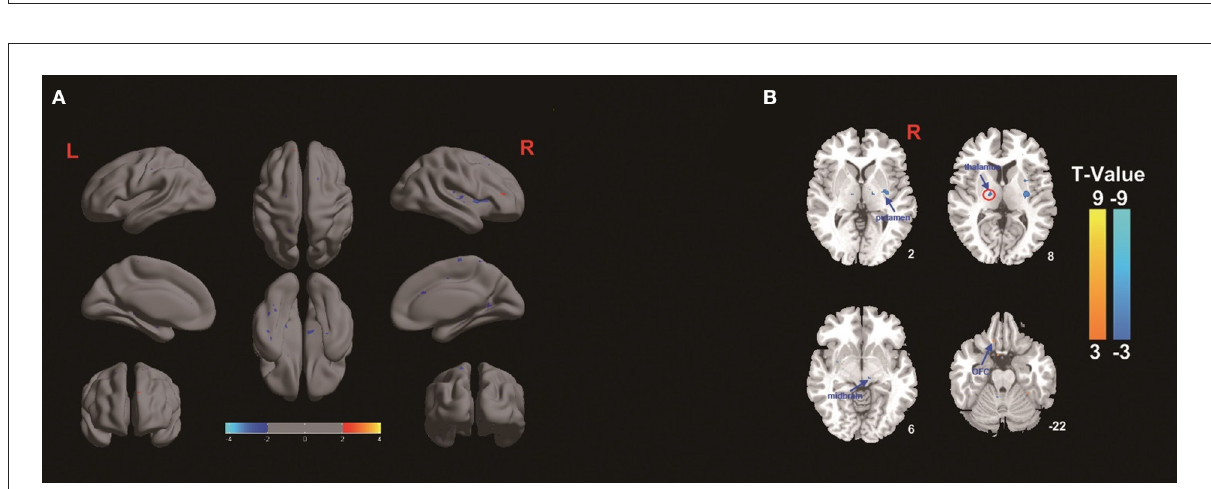
FIGURE3 (A,B) ALFF differences in healthy volunteers between the TEAS group and the control group. The warm color shows increased ALFF values in the OFC in the TEAS group, while the cold color shows decreased ALFF values in the left thalamus, right putamen, and midbrain in the TEAS group. F, The amplitude of low-frequency fluctuation; OFC, orbitofrontal cortex; TEAS: transcutaneous electrical acupoint